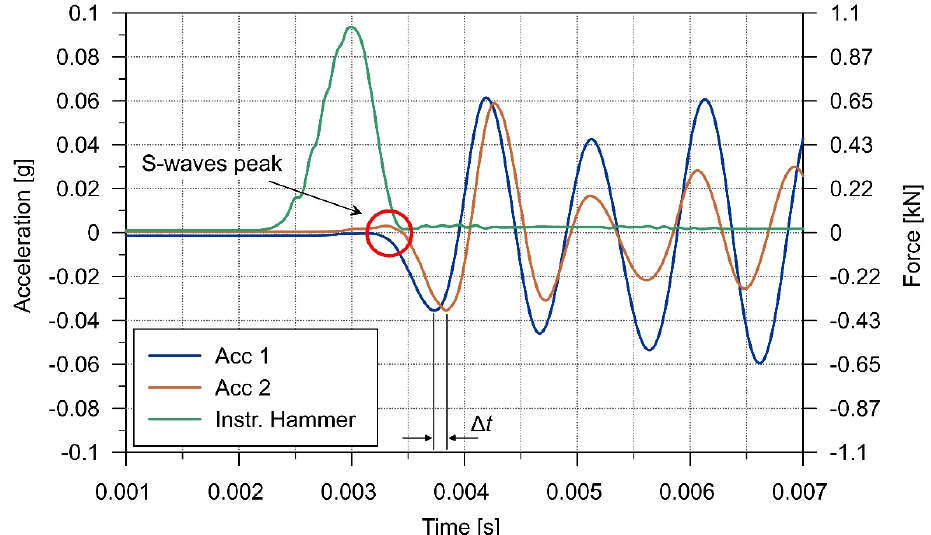
Figure 6. Typical signals recorded on the CLS2 wall by a couple of accelerometers 0.20 m apart and placed at a distance of 1.60 m between the source and the sensor Acc 1. The red circle highlights the passage of the S-waves. Table 1. Properties of concrete walls CLS1 and CLS2 and impact tests results: mass density ρ ; Pois- son ratio ν ; distance between the measurements points d ; number of suitable samples used in the analysis; mean of R-waves velocity 𝑉(cid:3364) (cid:3019) ; standard deviation of R-waves velocity 𝜎 (cid:3023) waves velocity with a confidence level of 95%; Young modulus E .